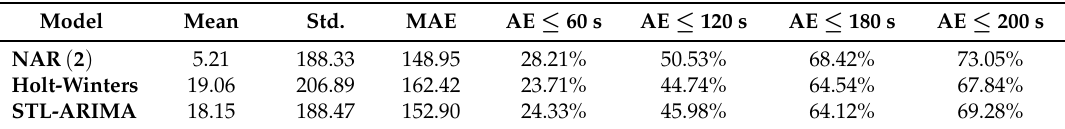
Table 6. Queuing time prediction errors of different models.